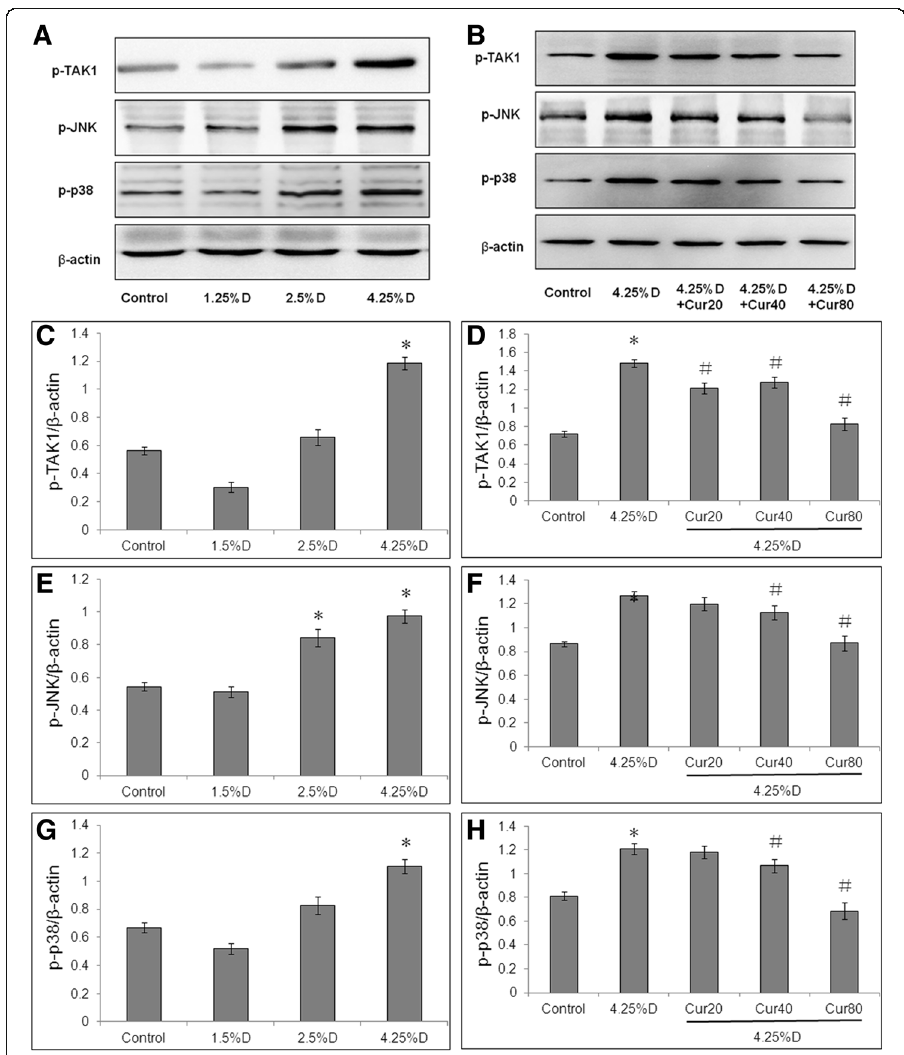
Fig. 4 Effect of curcumin on PD-induced p-TAK1, p-JNK and p-p38 activation in HMrSV5 cells. Cells were divided into control group (cells treated with DMEM/F12 medium containing 0.5%FBS), three PD groups (cells treated with 1.5% Dianeal, 2.5% Dianeal and 4.25% Dianeal) and three 4.25% Dianeal + curcumin group (cells treated with 4.25% Dianeal plus curcumin of 20, 40 and 80 μ M). After incubation for 24 h, cells were lysed using RIPA buffer for western blot assay, respectively. Representative immunoblots of p-TAK1, p- JNK, p-p38 and β -actin in HMrSV5 cells under various treatments is shown in ( a , b ). β -actin served as a loading control. After normalizing to protein bands grayscale of β -actin, relative intensity of p-TAK1 ( c , d ), p- JNK ( e , f ) and p-p38 ( g , h ) are shown in HMrSV5 cells under various treatments. * P < 0.05 vs. control group, # P < 0.05 vs. 4.25% Dianeal